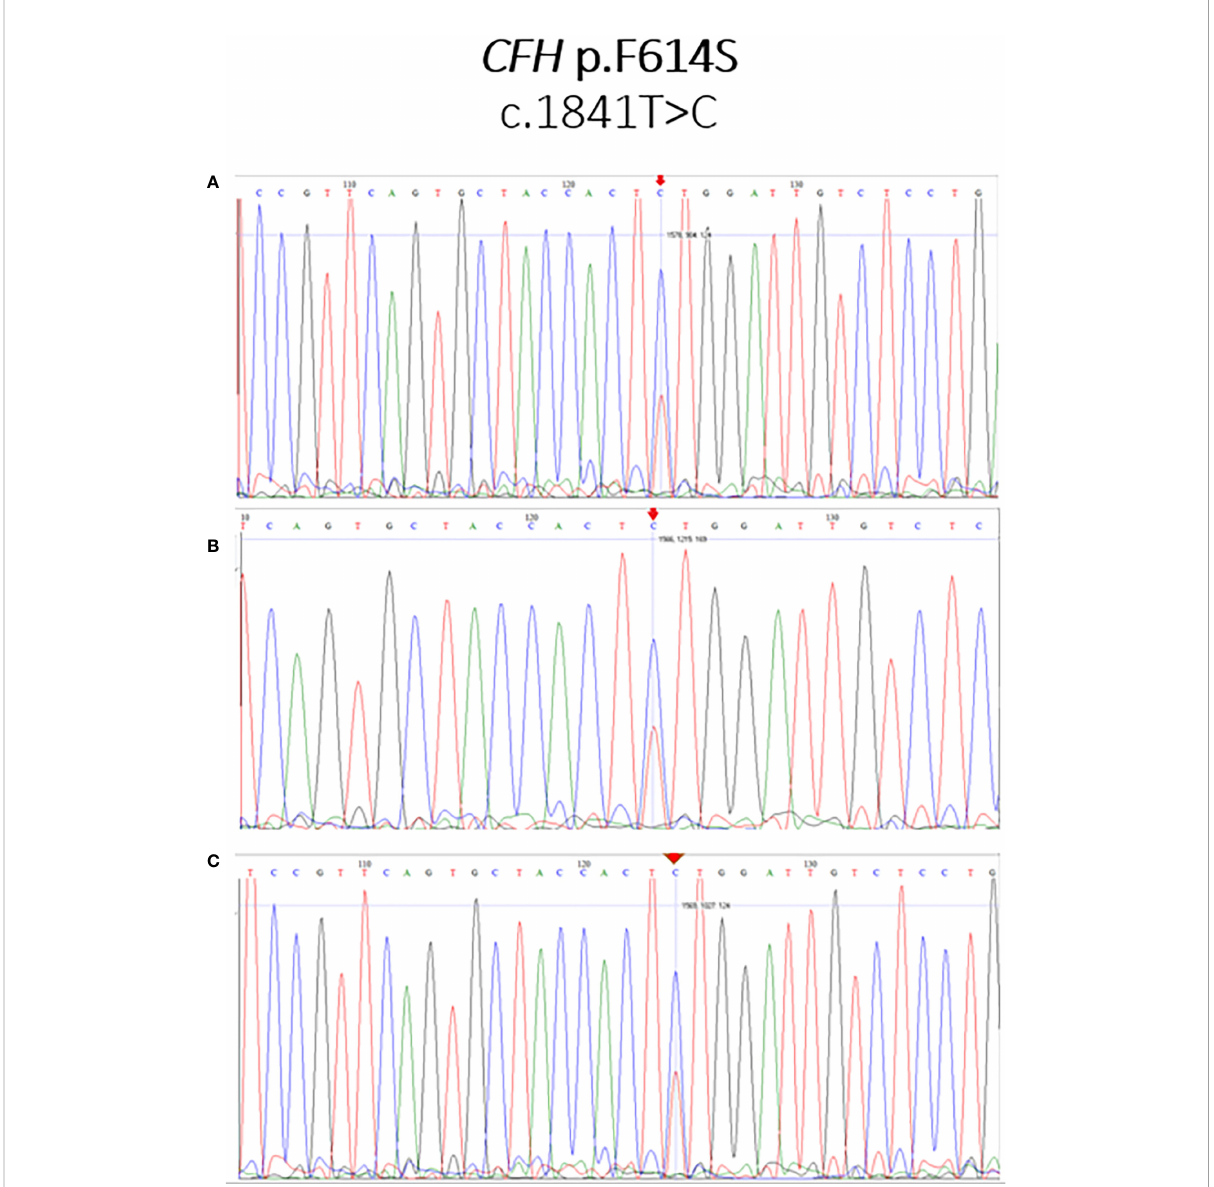
FIGURE 2 Sanger sequencing validation of the novel variant CFH:c.1841T>C (F614S). The mutation CFH:c.1841T>C (F614S), identi fi ed as T/C heterozygote, is marked by an arrow. Illustrative examples for the patients LN21 (A) , PI20 (B) , and PI22 (C) are